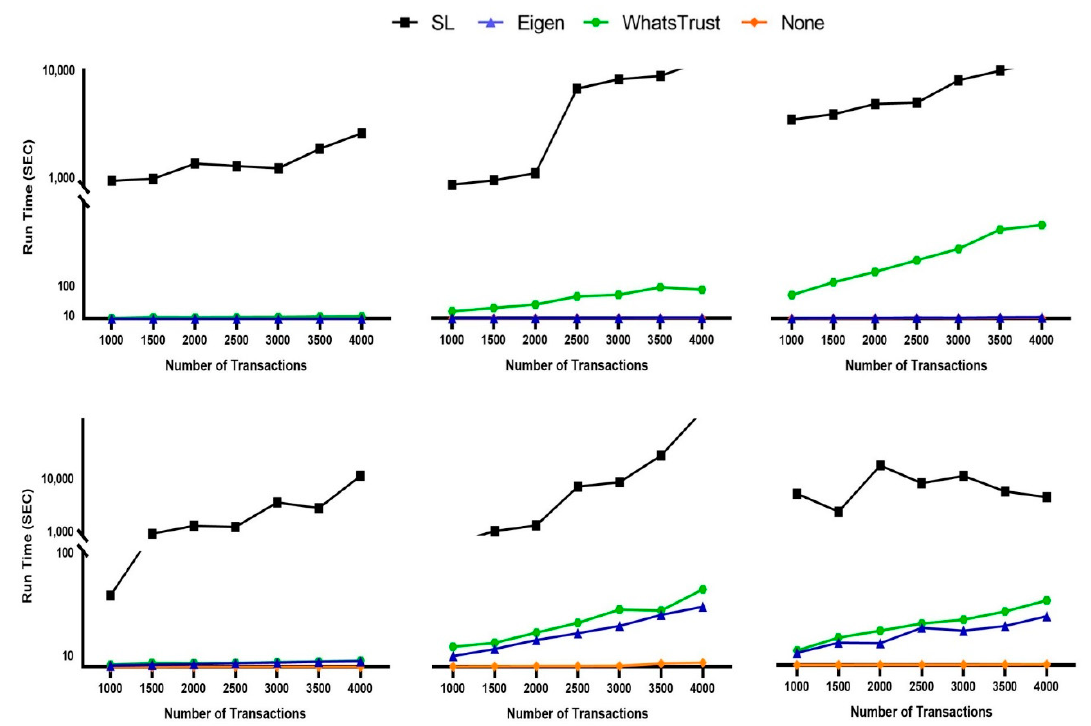
Figure 9. Execution times for EigenTrust, trust network analysis with subjective logic (TNA-SL), WhatsTrust, and none.